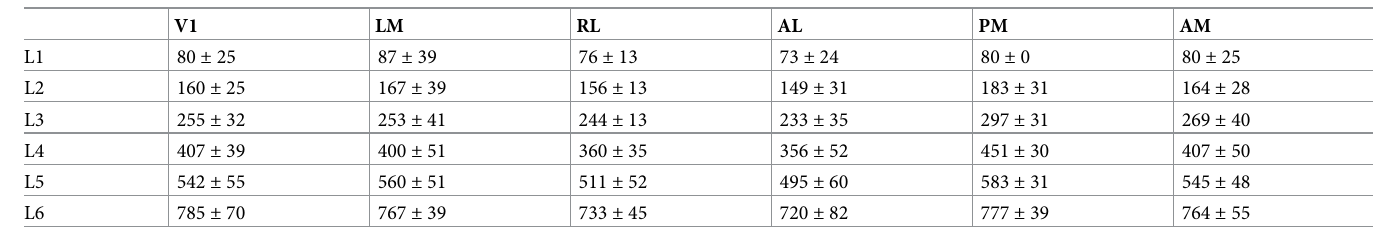
Table 1. Average cortical depth of selected channels for each layer and area (mean ±